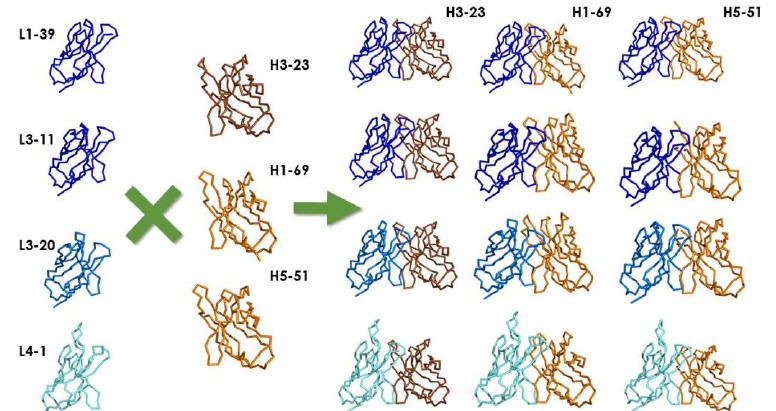
Figure 3. X-ray structures of scaffold combinations used to build Janssen Bio’s pIX Fab libraries. The figure was generated with The Molecular Operating Environment (MOE)